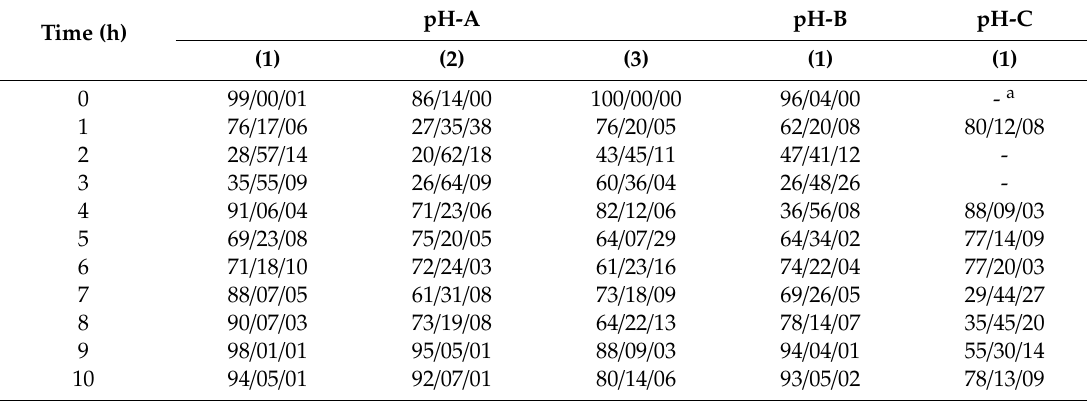
Figure 8. Plot of FL 1 against FL 2 fluorescence intensities of hourly samples showing dynamics of clusters observed during fermentation, shown for one representative pH-A batch (Plots for other batches shown in Appendix A). Table 3. Percentage event counts from clusters C 1 (live)/C 2 (intermediate)/C 3 (dead).